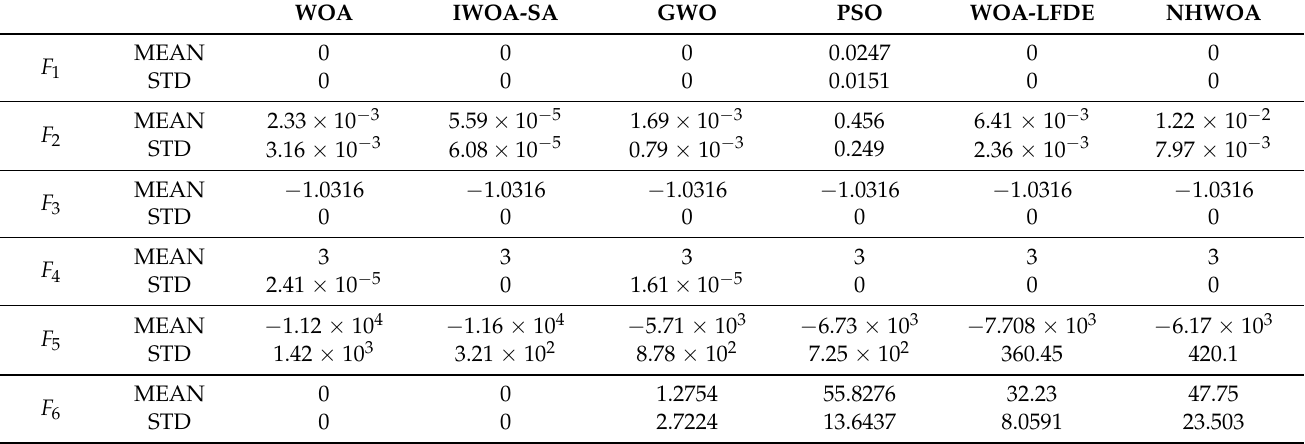
Table 4. Comparison of test-function